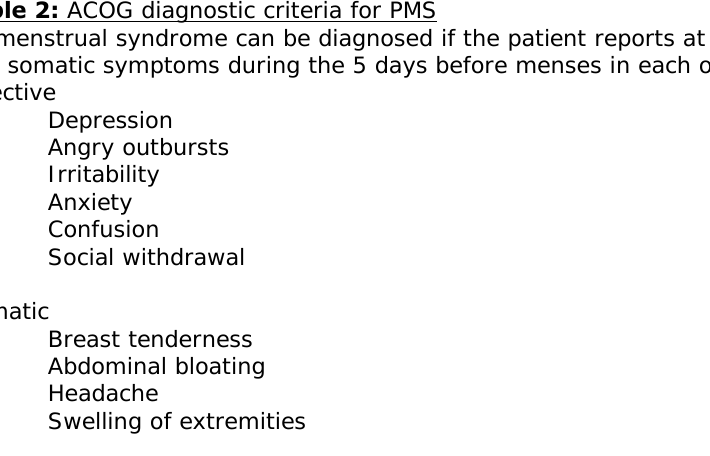
Table 2: ACOG diagnostic criteria for